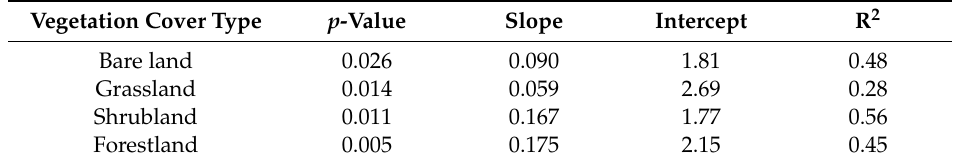
Table 8. Significance level of Spearman correlation and regression analysis between increases in volumetric soil moisture content and the amount of rainfall per precipitation event.